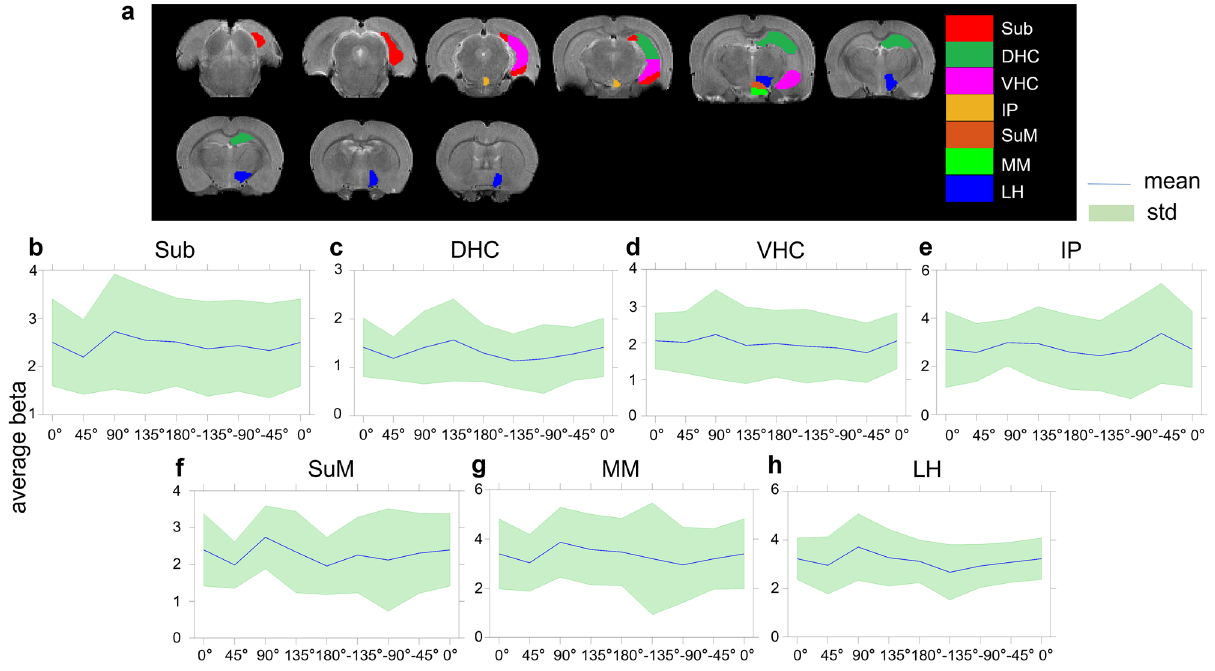
Figure 5. ROI analyses of OS-DBS in the MSN (n = 8). The locations of the primary ROIs are shown on T2-weighted MRI images ( a ). Average beta values are shown for the ROI in the subiculum, Sub ( b ); dorsal hippocampus, DHC ( c ); ventral hippocampus, VHC ( d ); interpeduncular nucleus, IP ( e ); supramamillary nuclei, SuM ( f ); mammillary bodies, MM ( g ); and lateral hypothalamus, LH ( h ). The blue line and green area represent the mean value and standard deviation among rats, respectively. None of the angles reached p < 0.05, corrected (linear mixed model comparisons vs − 90°, adjusted for Bonferroni multiple comparisons correction). Coronal brain images are displayed in neurological convention (left corresponds to the left side of the brain). Stimulation frequency was 130